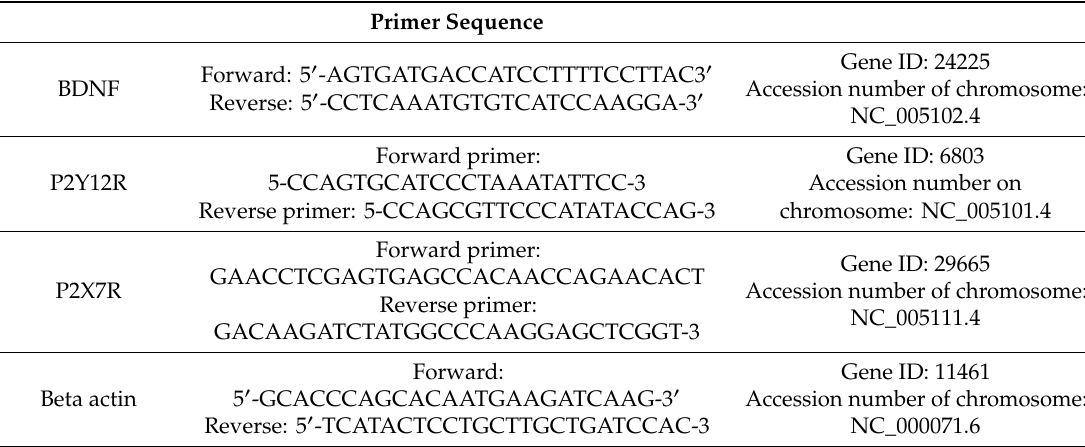
Table 1. Primers used for real-time quantitative